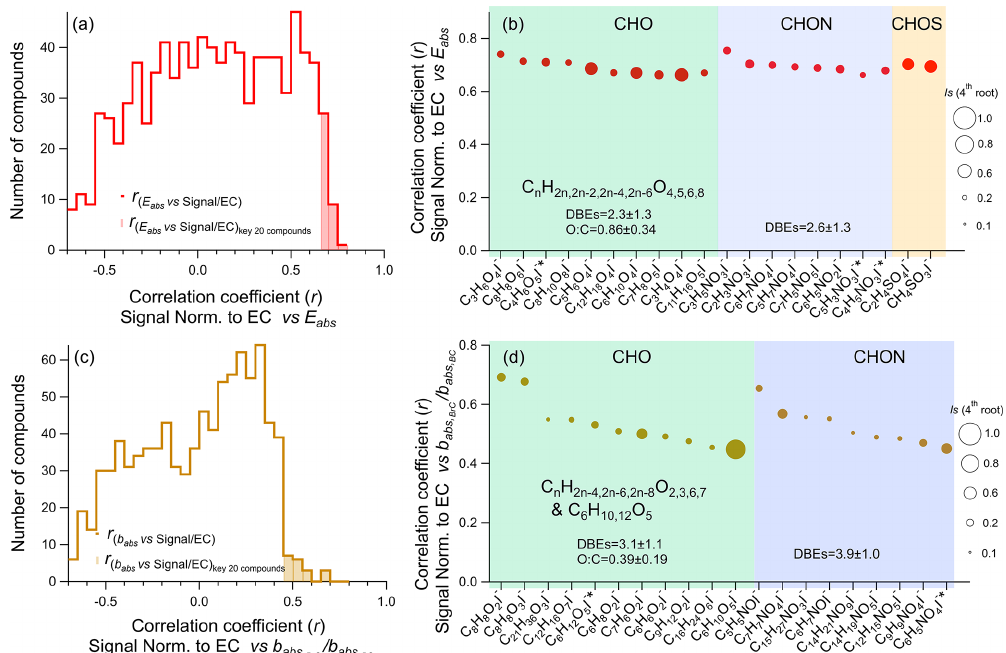
Figure 6. (a) Histogram of the correlation coefficients ( r ) between the normalized OA signals and E abs at 880nm for all identified com- pounds (red line) and the 20 key compounds (red-shaded area); (b) the correlation coefficients of the 20 key compounds for E abs at 880nm; (c) histogram of the correlation coefficients between the normalized OA compound signals and b abs , BrC /b abs , BC at 370nm for all identi- fied compounds (brown line) and the 20 key compounds (brown-shaded area); (d) the correlation coefficients of the 20 key compounds for b abs , BrC /b abs , BC at 370nm. The size of the symbols in (b) and (d) is proportional to the fourth root of the average signal intensities of the corresponding compound during the whole sampling period. Compounds that possibly have a substantial contribution of larger thermally fragmented parent compounds are marked with ∗ in the axis